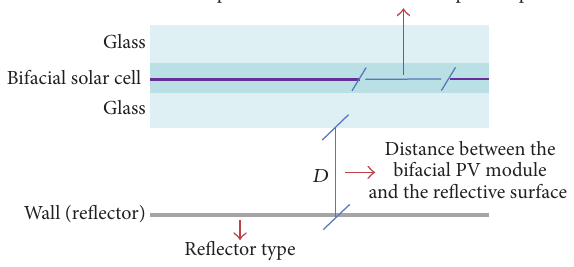
Figure 1: Key parameters affecting the bifacial PV performance.